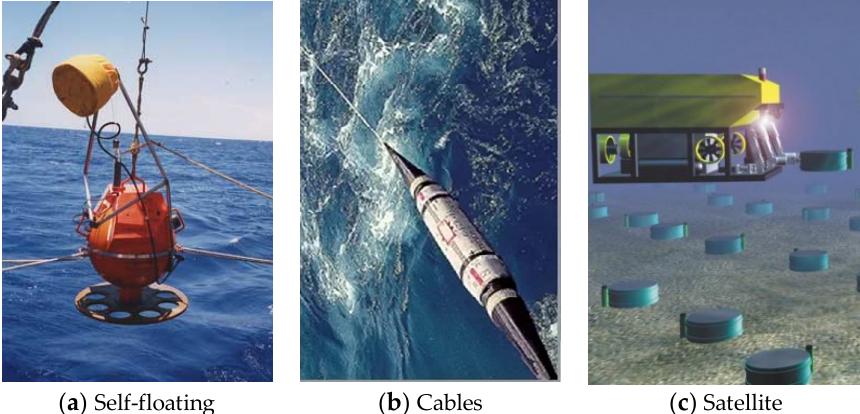
Figure 1. Various types of Ocean Bottom Seismometers (OBSs) placed on the seafloor.